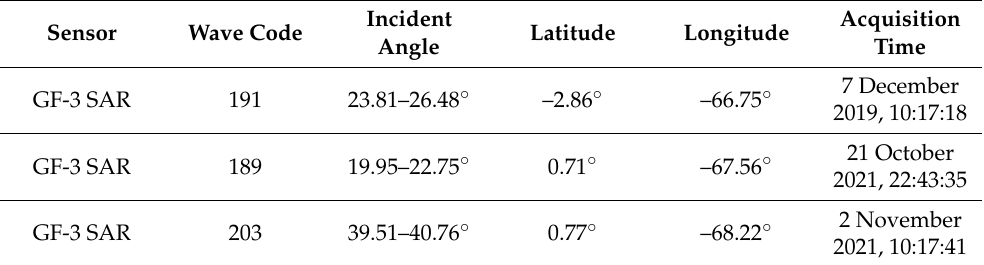
Figure 2. Quad-polarization SAR sub-imagery of rainforest used in this study: ( a – d ) Represents the HH, HV, VH, VV polarization, respectively. Table 2. Parameters of used datasets in this study.